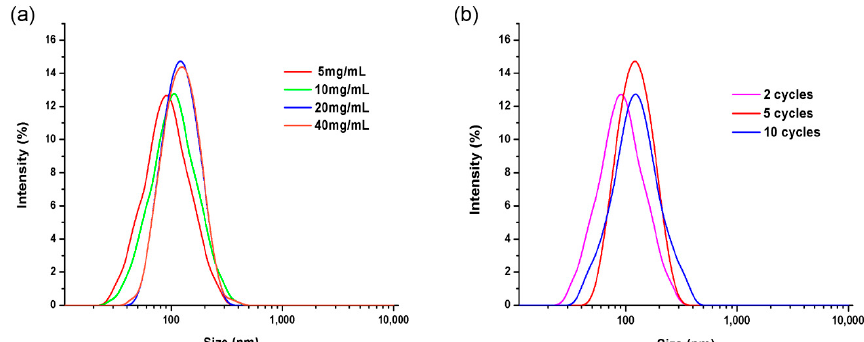
Figure 2. BNPs fabricated with AAO templates with 100 nm pore sizes in different drug concentration (5, 10, 20, 40 mg/mL) with different cycles (2, 5, 10 cycles). ( a ) DLS image of BNPs in different drug concentration (5, 10, 20, 40 mg/mL), ( b ) DLS image of BNPs with different cycles (2, 5, 10 cycles).